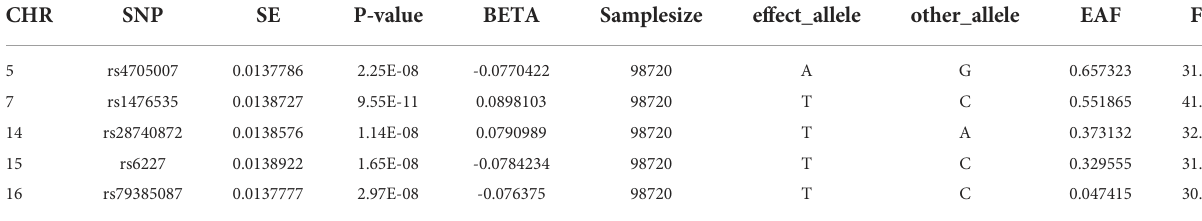
TABLE 2 Single-nucleotide polymorphisms associated with trauma